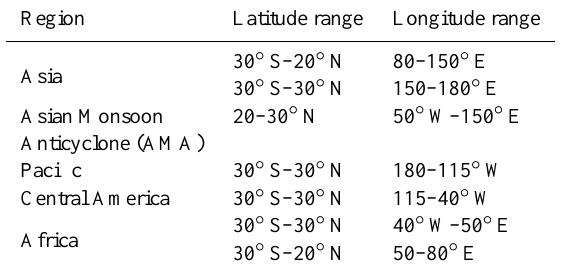
Table 1. Regions used in the study.